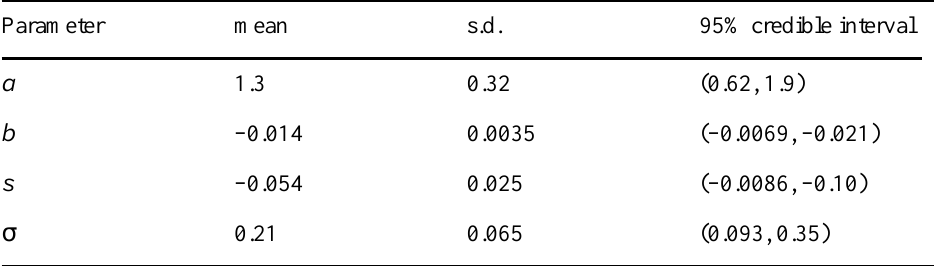
Table 1. Mean, standard deviation (s.d.) and 95% credible interval for the posterior distributions of the parameters of the population